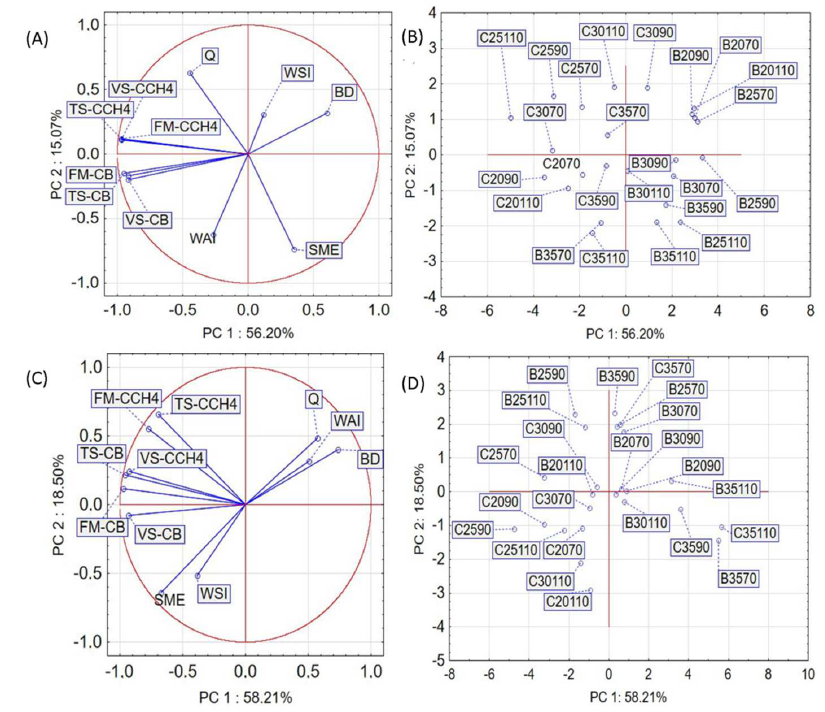
Figure 14. Principal component analysis (PCA) before ( A ) and after modification ( C ) and objects